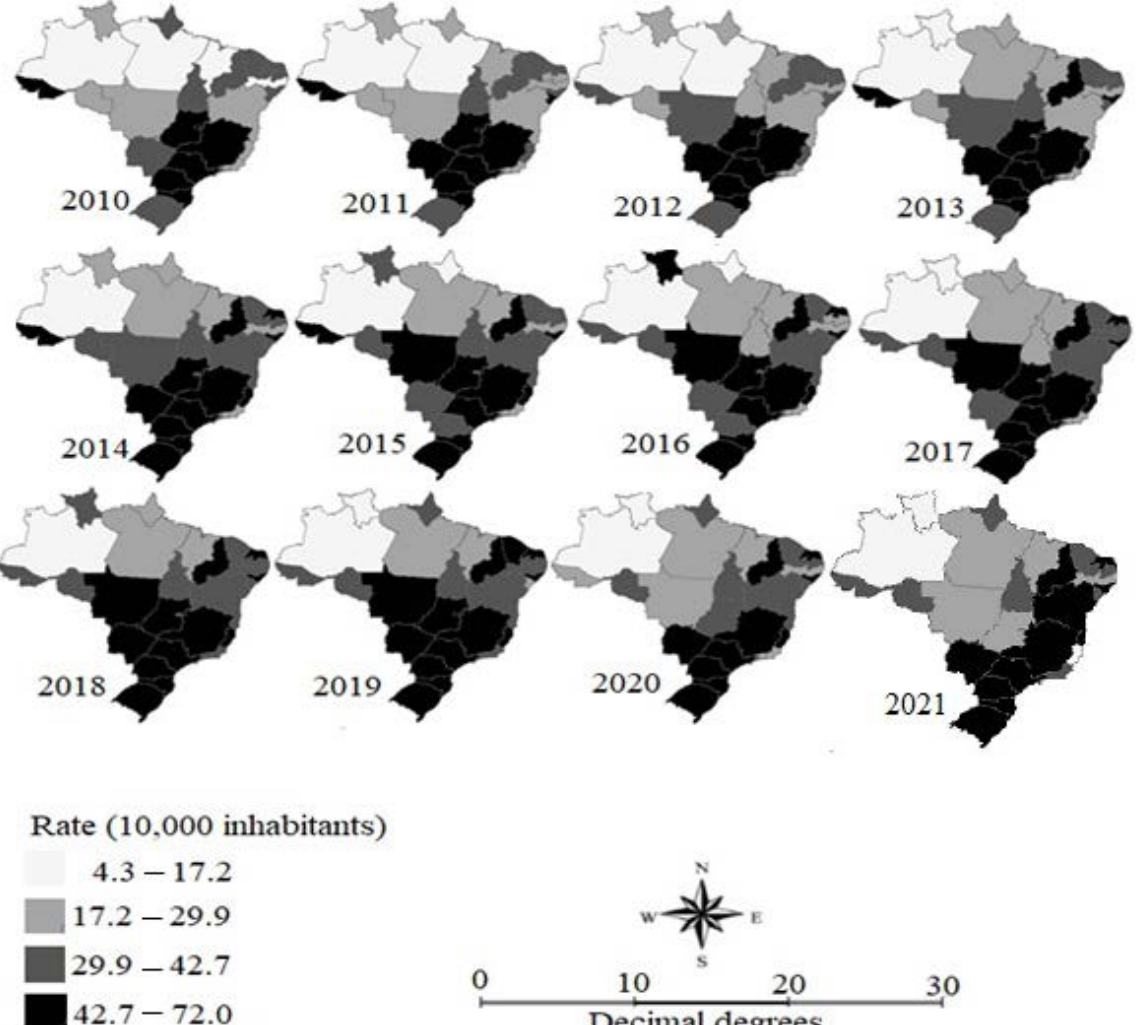
Figure 2. Thematic mapping of the smoothed fall-related hospitalization rate in elderly people per 10,000 people in Brazilian federative units, 2010 to 2021. Source: Brazil [13].